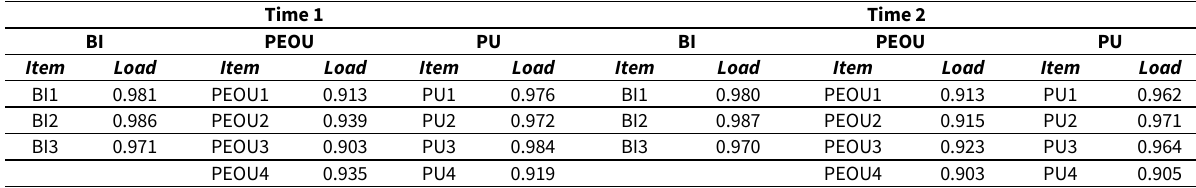
Table 5. Outer loadings for each construct